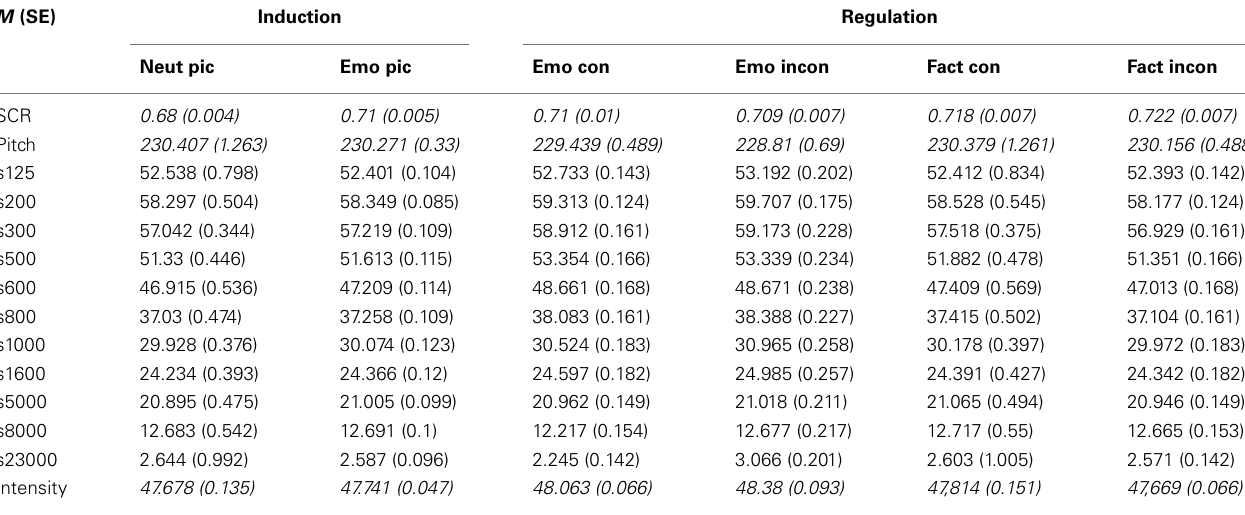
Table 3 | Results from the random-intercept models of the voice analysis for emotion induction (effect of picture) and regulation (effect of strategy).